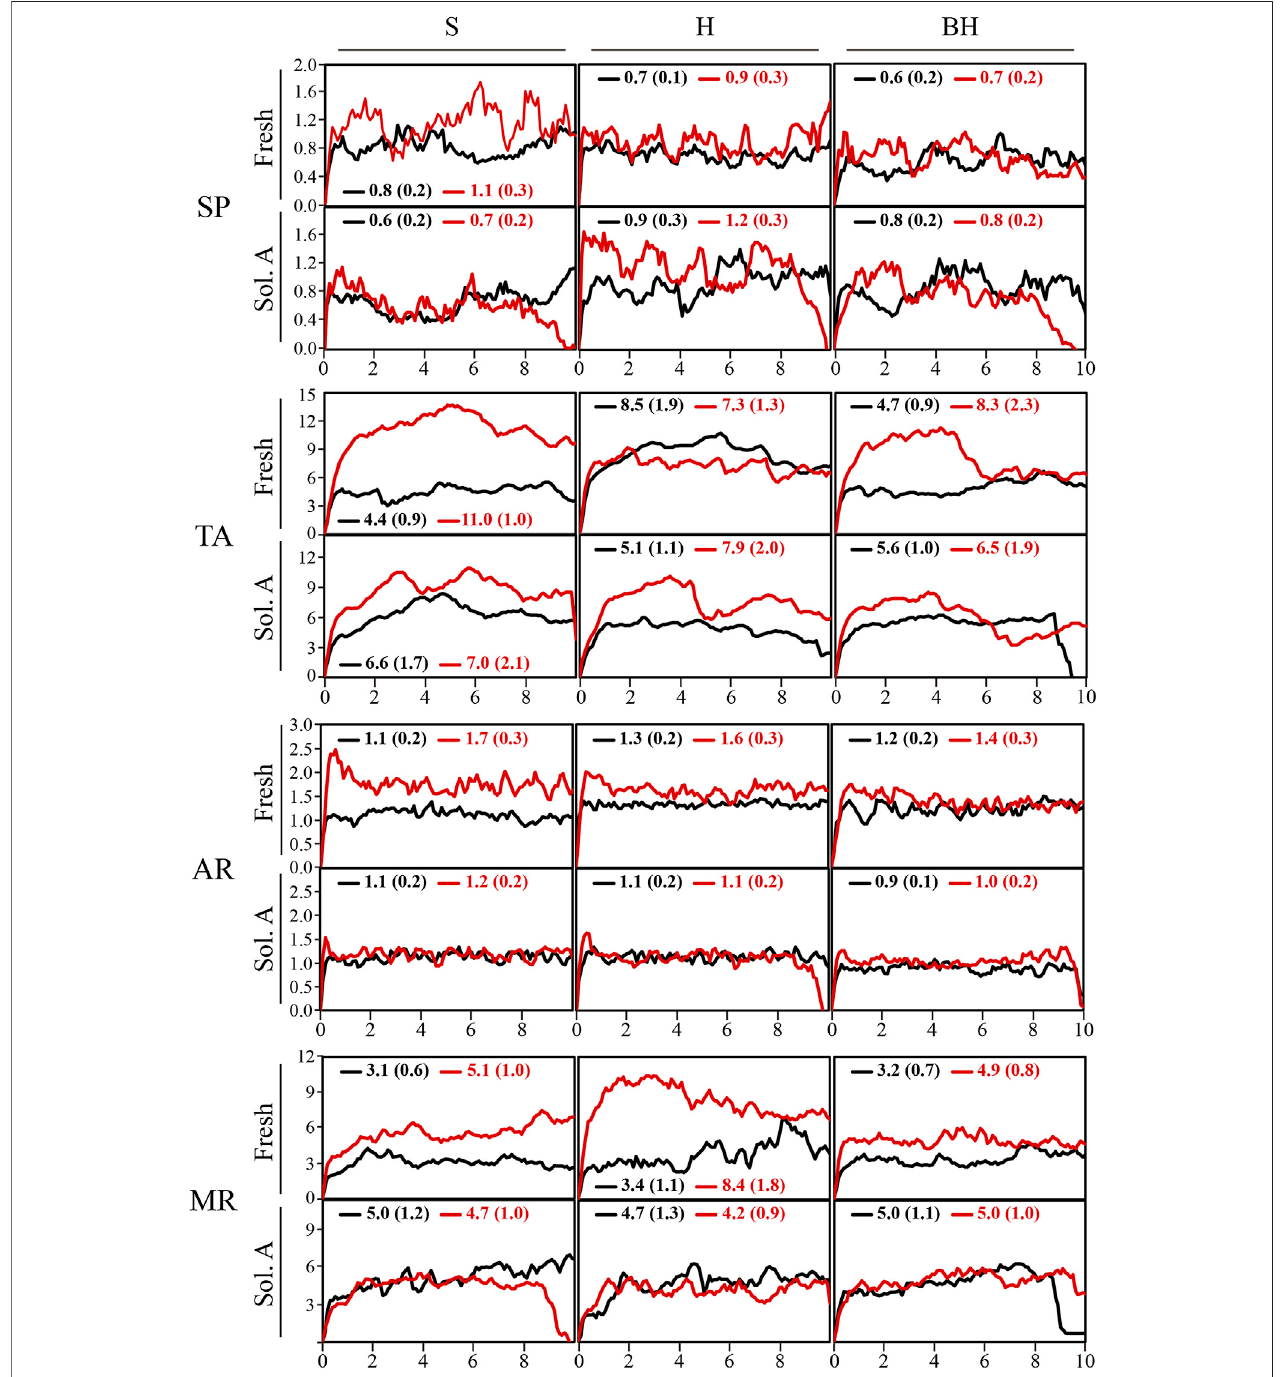
FIGURE 5 | Diagrams for resistance to drilling (R D ) of fresh samples (Fresh) and of altered samples exposed to Solution A (Sol. A) untreated (black line) and treated (red line) for the four varieties of rock and the three different surface fi nishes (S-saw-cut, H-honed and BH-bush-hammered). The resistance values are represented on the y-axis (R D , in N/mm) and the depth of penetration (in mm) on the X -axis. Legend: SP, Calcarenita de Santa Pudia; TA, Travertino Amarillo; AR, Arenisca Ronda; MR, Molinaza Roja. The numbers inside the plots represent the average value of R D and their respective standard deviation (in brackets).